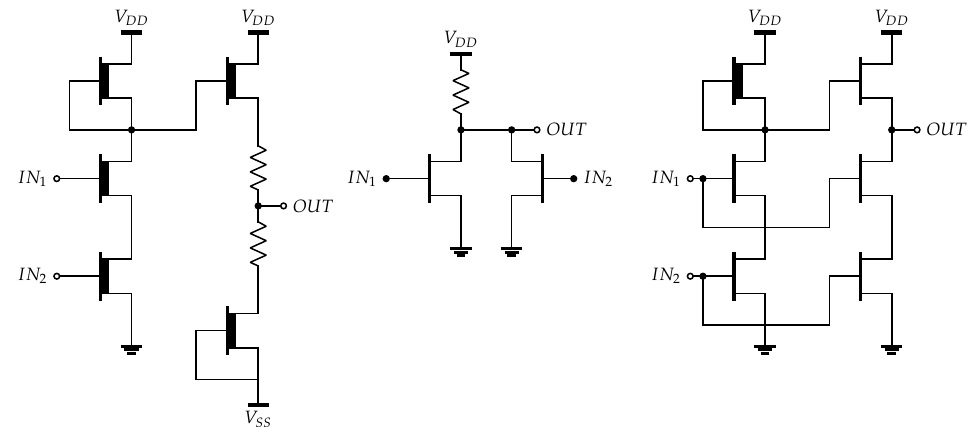
Figure 4. Examples of NAND and NOR gates in different FET logic families: ( left ) HVR-BFL 2-input NAND, ( center ) E-DCFL 2-input NOR, ( right ) SBFL 2-input